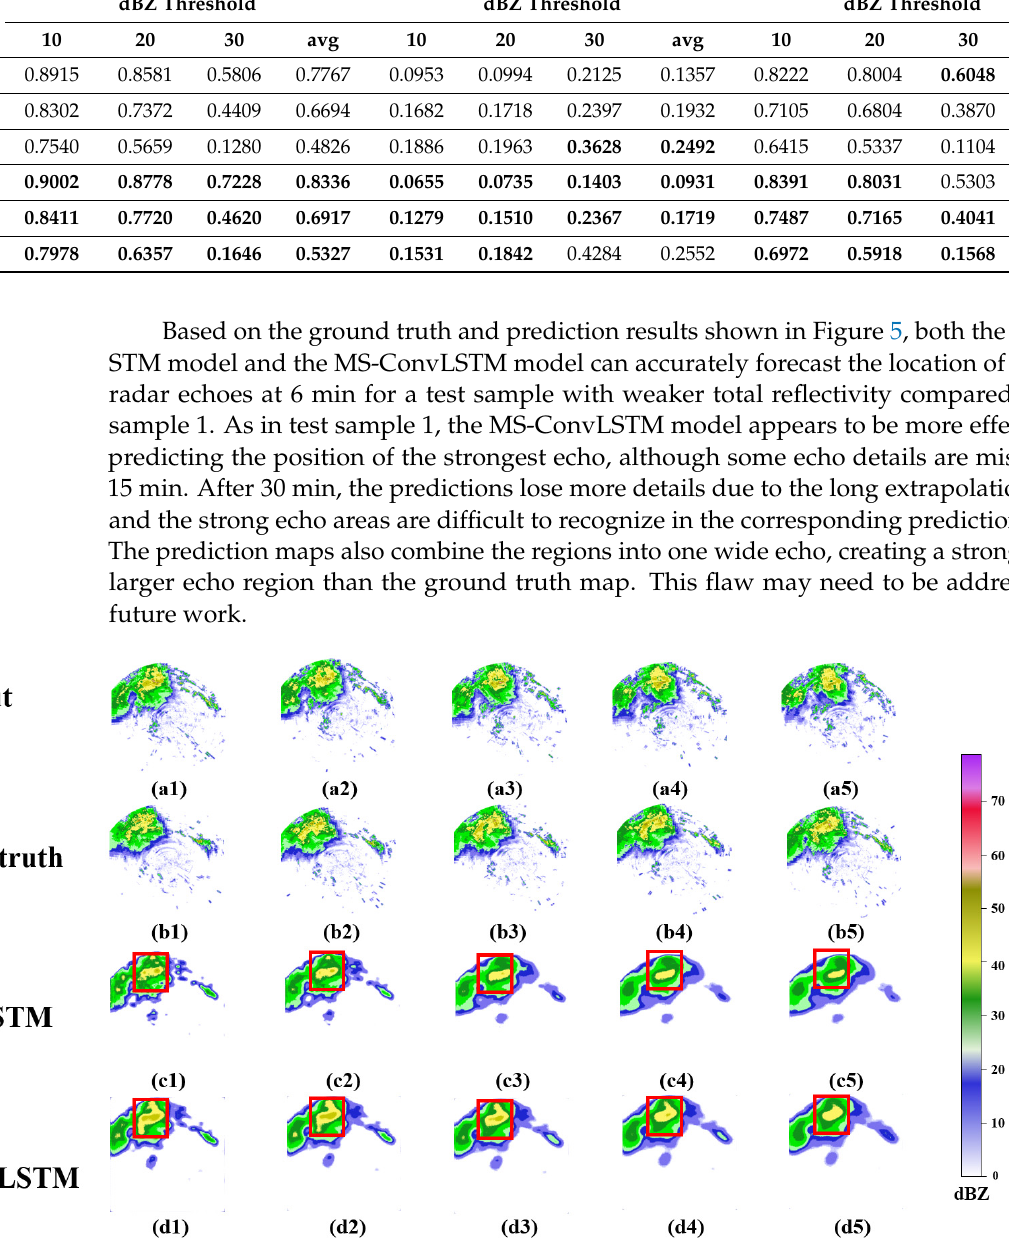
Figure 5. The visualization results of test sample 2: ( a1 – a5 ) represent part of the input of the model; ( b1 – b5 ) are the ground real radar echo images of 6, 18, 30, 42 and 60 min; and ( c1 – c5 ) and ( d1 – d5 ) are the corresponding prediction results of ConvLSTM and MS − ConvLSTM, respectively.